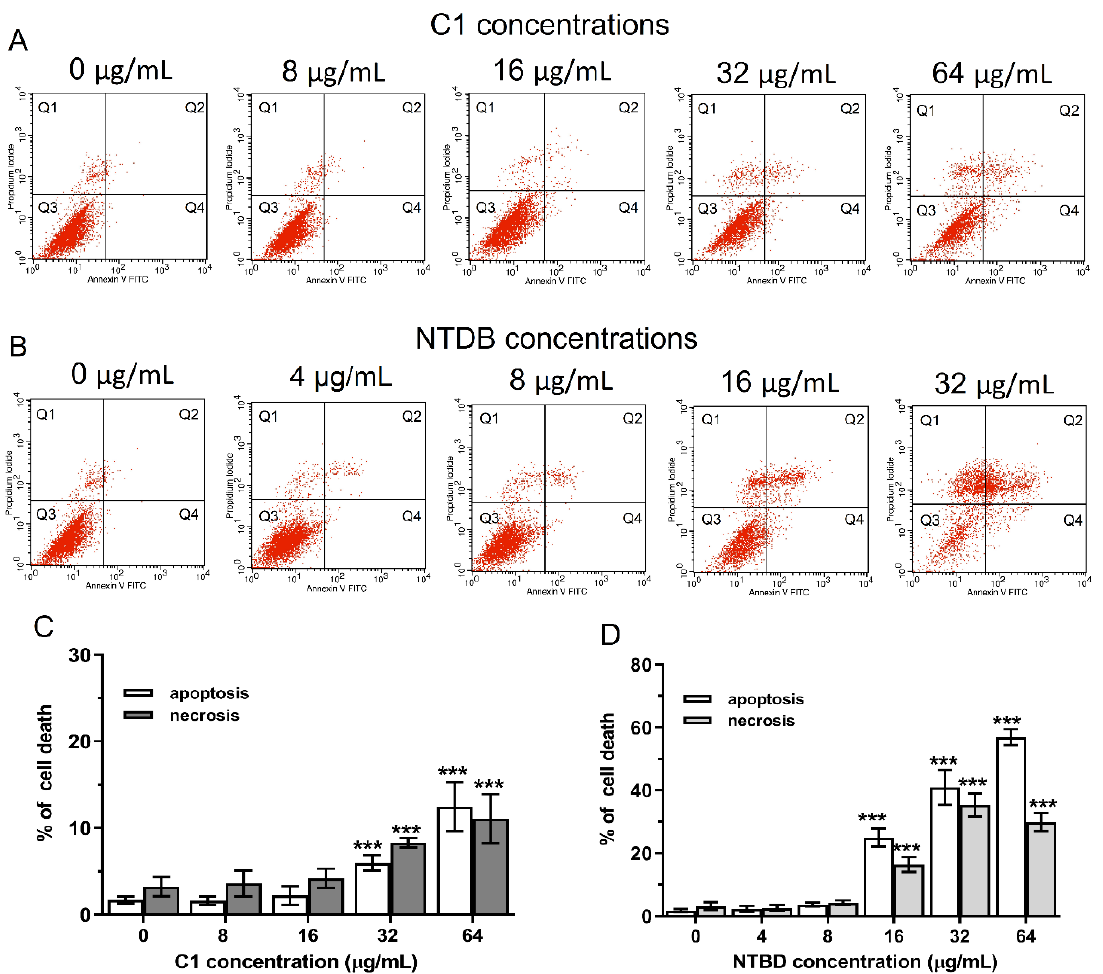
Figure 3. Impact of C1 and NTBD on the induction of apoptotic and necrotic cell death in the RPTEC cells. Following the 24 h incubation with or without the increasing concentrations of C1 or NTBD, the cells were double stained with Annexin-V/PI and analyzed with flow cytometry. Histograms ( A ) and ( B ) show the population of viable and dead cells, and quantitative analyses of the percentage of apoptotic (early + late apoptosis) and necrotic cells are presented in the form of bar graphs ( C ) and ( D ), for C1 and NTBD, respectively. Each red dot on the dot plots indicate single event/cell. Values are significantly different from the vehicle control if p < 0.001 *** in the one-way ANOVA test. Results are shown as a representative of three independent experiments. Abbreviations: Q1—An- /PI+ necrotic cells, Q2—An+/PI+ late apoptotic cells, Q3—An-/PI- viable cells, Q4—An+/PI- early apoptotic